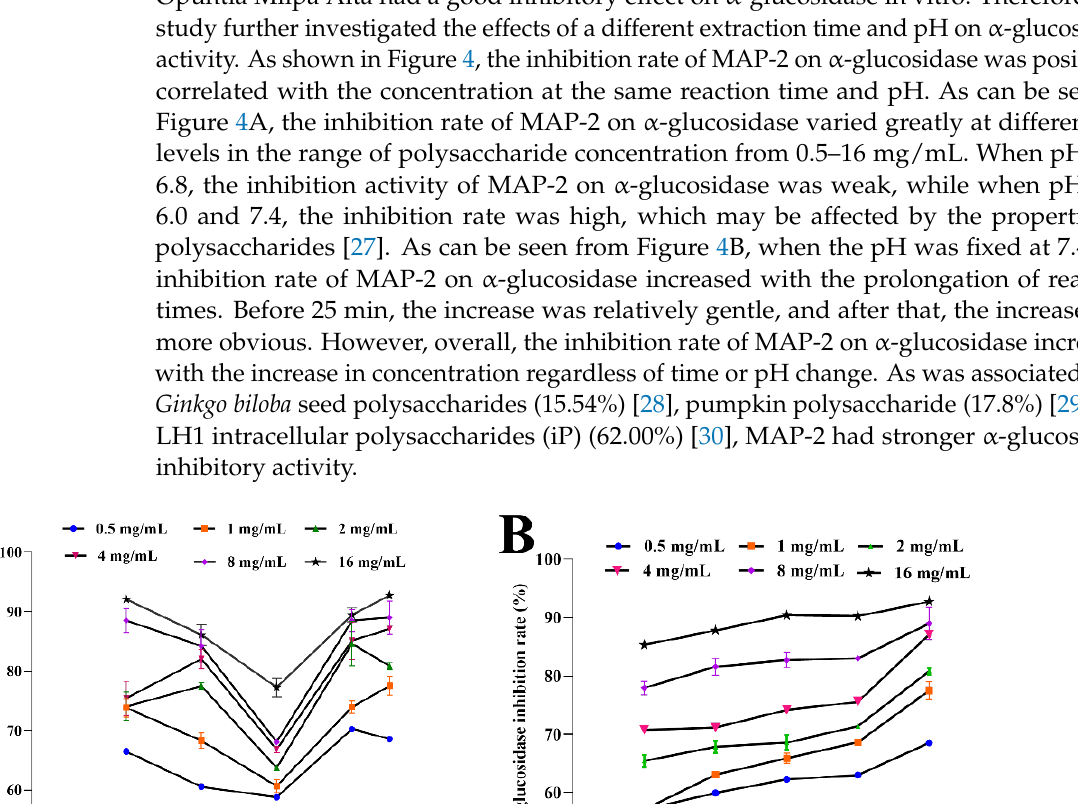
Table 4. Predicted and experimental values of the responses at optimum and modified conditions.